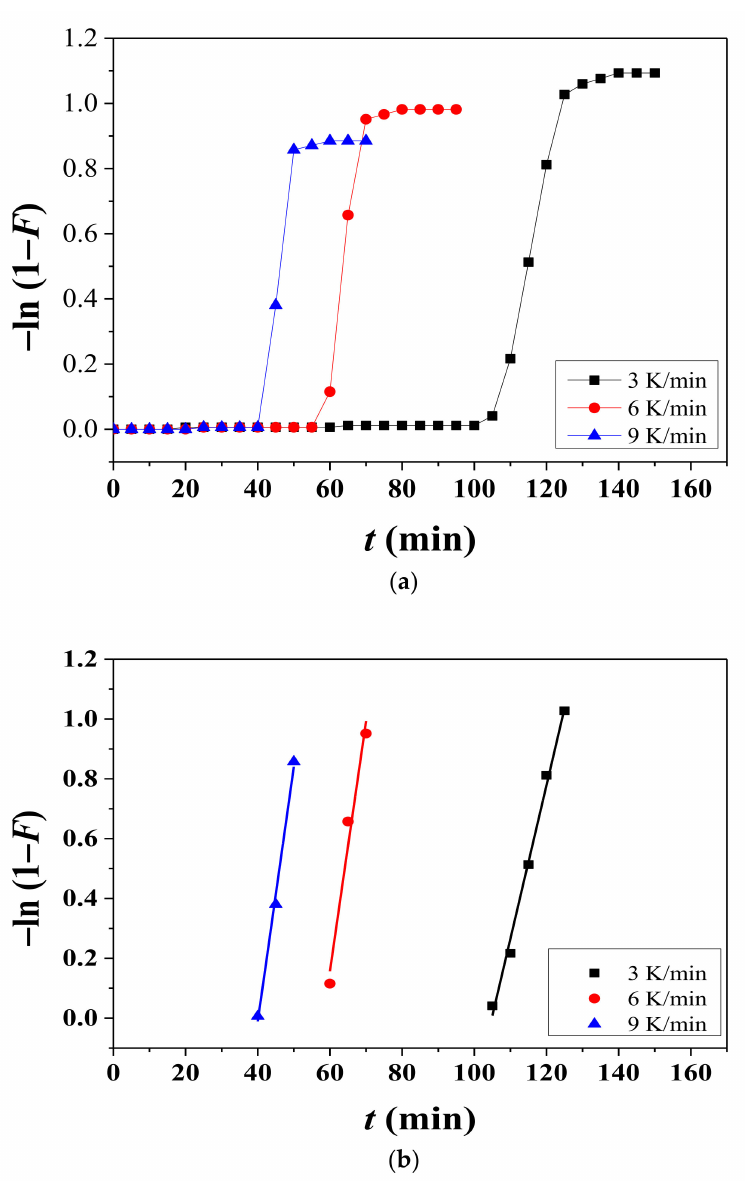
Figure 4. ( a ) Variations in − ln (1 − F ) with t at heating rates of 3, 6, and 9 K/min at 593 K under 1.0 bar H 2 for hydrided Mg–5Ni and ( b ) variation in − ln (1 − F ) with t in the range where most of the hydrogen absorbed during hydriding is